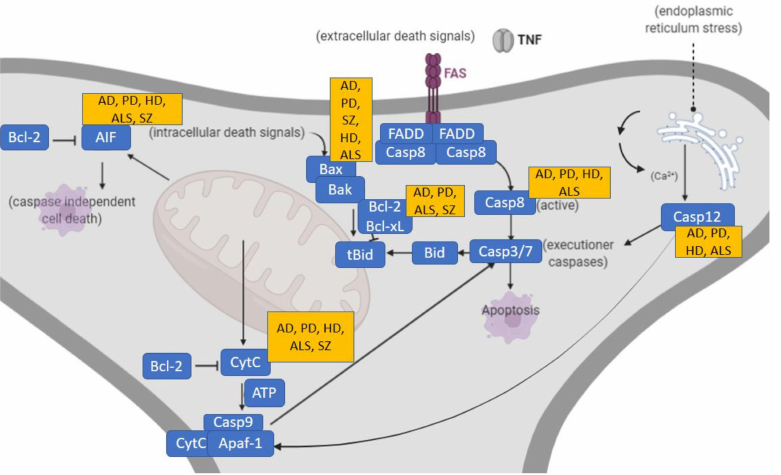
Figure 2. Two prototypical apoptotic pathways (extrinsic and intrinsic) initiated by separate events converge at a common place to execute apoptosis. Main associations of these apoptotic pathways to the neurodegenerative disorders AD, PD, HD as well as SZ are indicated. Death receptor pathways triggered by binding of death receptors by their ligands (tumor necrosis factor (TNF, FasL) that results in receptor clustering and recruitment of adaptor proteins, leading to the activation of initiator caspase- 8. The intrinsic pathway responds to a variety of cellular stress signals that act on mitochondria to cause leakage of pro-apoptotic effectors like cytochrome c and apoptosis-inducing factor (AIF). Cytochrome c binds to Apaf-1 in the presence of ATP to form the “apoptosome”, which subsequently recruits and activates initiator pro-caspase-9. AIF translocates to the nucleus to cause high molecular weight DNA fragmentation in a caspase-independent manner. Both pathways activate effector caspases-3 and -7. Endoplasmic reticulum stress causes the activation and release of caspase-12, leading to apoptotic cell death. AIF, apoptosis-inducing factor; AD, Alzheimer’s disease; ALS, amyotrophic lateral sclerosis; Apaf, apoptotic protease activating factor; Bak, Bcl-2 homologous antagonist killer; Bax, Bcl-2 associated X protein; Bcl, B-cell lymphoma; Bid, BH3 interacting domain death agonist; Casp, caspase; CytC, cytochrome c; FADD, Fas-associated-death-domain protein; FAS, cysteine-rich transmembrane protein CD95; HD, Huntington’s disease; PD, Parkinson’s disease; SZ, schizophrenia; tBid, truncated Bid; TNF, tumor necrosis